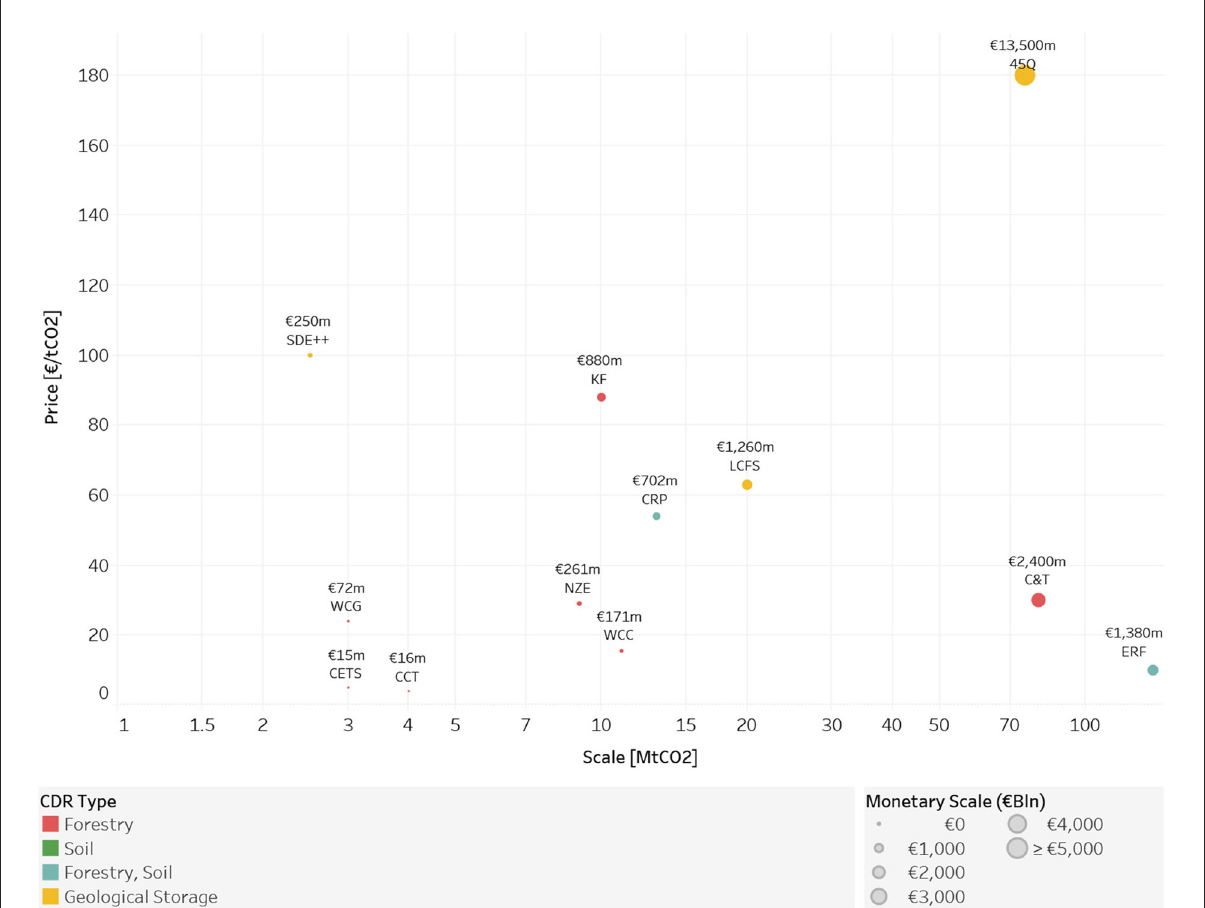
FIGURE2 Current potential scale and price of mechanisms by CDR type (converted from base currency to e in September 2022). Carbon pricing and markets: WCC, Woodland Carbon Code; C&T, California Cap and Trade; NZE, New Zealand ETS; LBC, Label Bas Carbone; RHC, Registro de Huella de Carbono; CCT, Colombia’s Carbon Tax; CETS, China ETS; QC, Québec Cap-and-Trade System; KE, Korean ETS; KZE, Kazakhstan ETS; SETS, Saitama’s ETS; COETS, Colombia ETS. Tradeable obligation scheme: LCFS, Low-Carbon Fuel Standard; KF, Klik foundation; CTBO, Carbon Take Back Obligation. Results-based payments: WCG, Woodland Carbon Guarantee; ERF, Emissions Reductions Fund; CfD, Contract for Difference; SRA, Swedish Reverse Auction. Subsidy: CSS, Countryside Stewardship Scheme; WCF, Woodland Carbon Fund; 1BTF, One Billion Trees Fund; CRP, Conservation Reserve Program; HSP, CDFA Healthy Soils Program; SL, Sowing Life; IAS, Ireland’s Afforestation Scheme; PES, Costa Rica’s; NICFI, Norway’s; ELMS, Environment Land Management Scheme; RDH, Regional Direct Air Capture Hubs. Tax credit: 45Q,